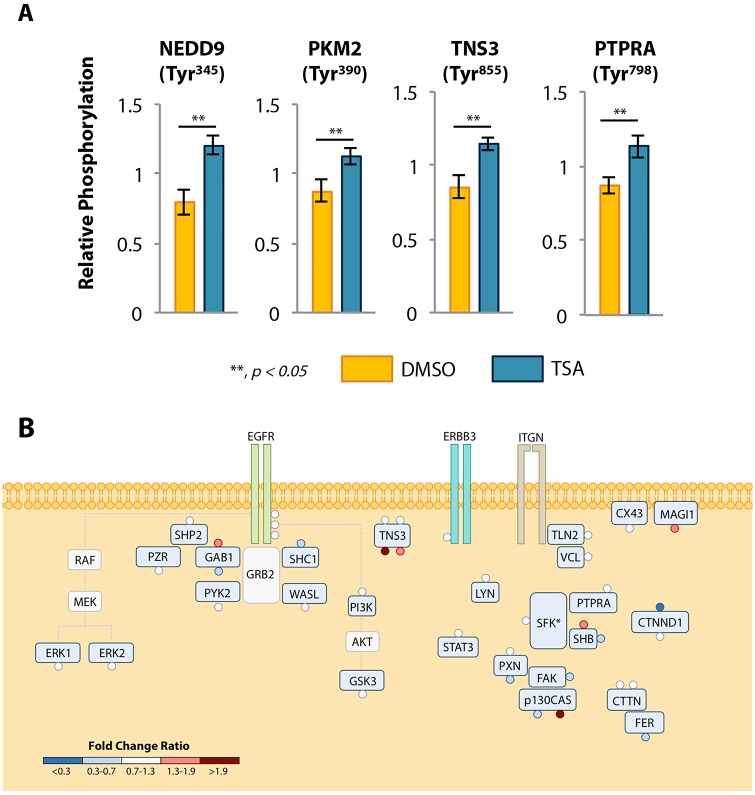
Quantitative phosphotyrosine profiling of A549 cells treated with the lysine deacetylase inhibitor, TSA, with or without EGF stimulation.
A. The four phosphotyrosine sites significantly (p<0.05) differentially phosphorylated between A549 cells treated with TSA or DMSO. Average phosphorylation +/- standard error are shown. B. The fold change ratio in response to TSA treatment mapped to a visual representation of proteins involved in kinase signaling, scaffolding, and cell adhesion. Each circle represents a unique phosphorylation site identified on the protein. Sites are color coded to characterize the relative effect of TSA pre-treatment on the EGF response. Proteins are labeled by their gene name. A larger version of the figure with labeled phosphorylation sites is available in S7 Fig.